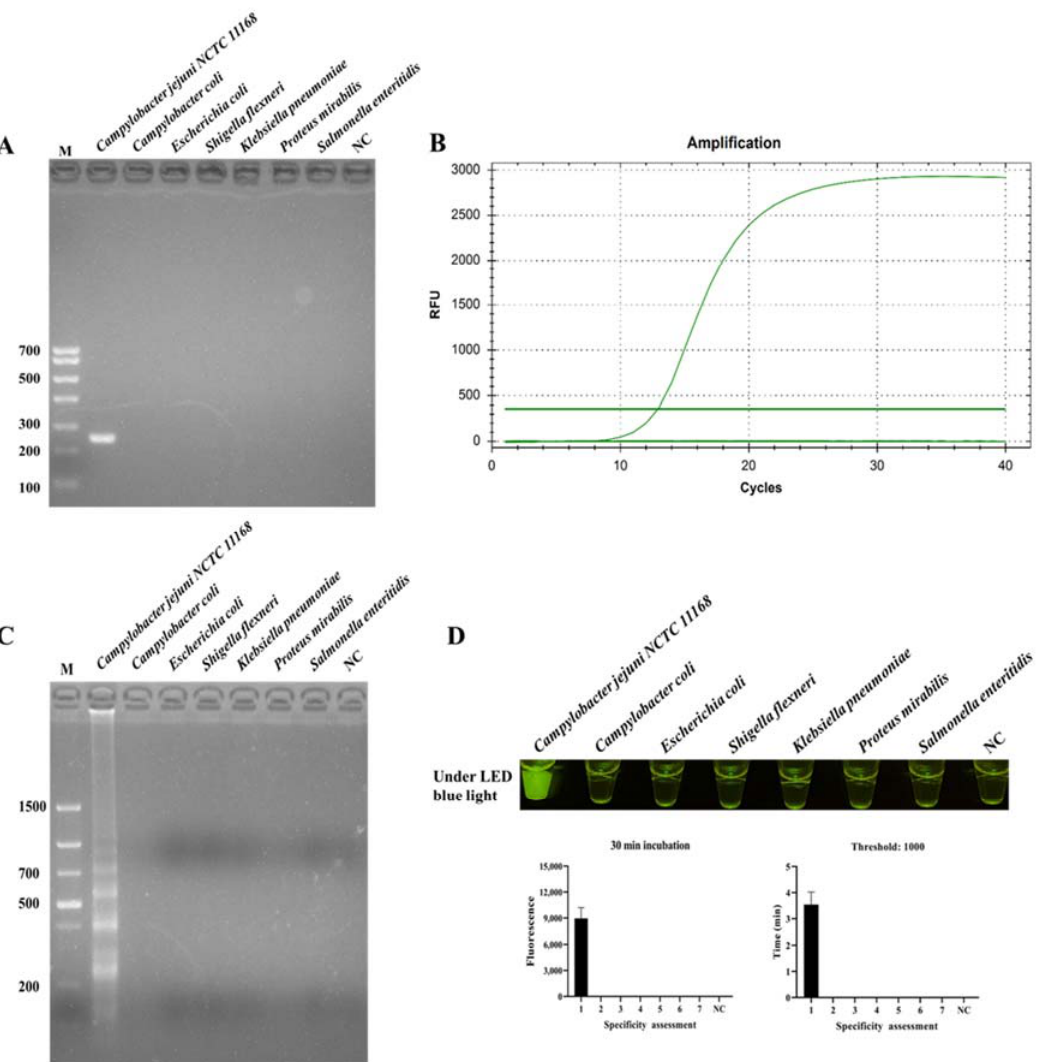
Figure 5. Specificity evaluation ICB-LAMP-CRISPR/Cas12a method. The specificity of ICB-LAMP-CRISPR/Cas12a was compared with PCR, qPCR, and LAMP. C. jejuni NCTC 11168 and 6 non- C. jejuni ( C. coli , E. coli , S. flexneri , K. pneumoniae , P. mirabilis , and S. enteritidis ) were used as the tested sample. The specificity evaluation results of PCR and LAMP were shown by agarose gel electrophoresis. The specificity evaluation results of qPCR and ICB-LAMP-CRISPR/Cas12a are shown by the real-time amplification curve and end-point fluorescence. ( A ) The specificity evaluation of PCR. ( B ) The specificity evaluation of qPCR. ( C ) The specificity evaluation of LAMP. ( D ) The specificity evaluation of the ICB-LAMP-CRISPR/Cas12a